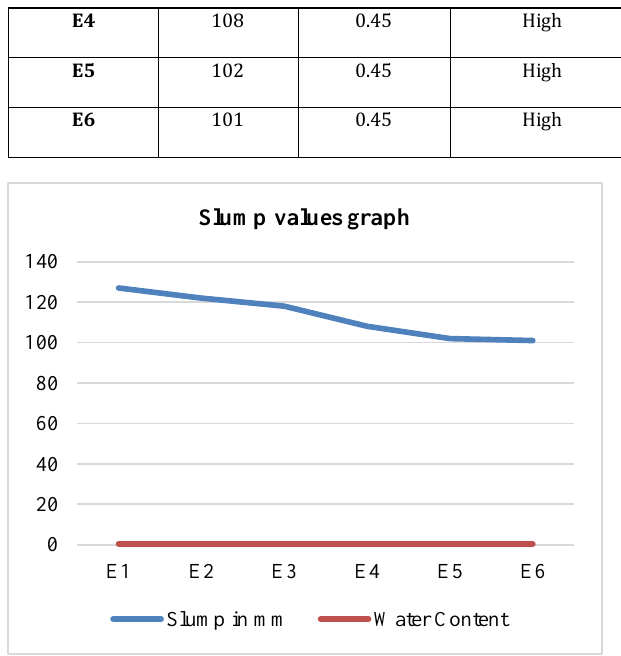
Figure 2: Slump value graph